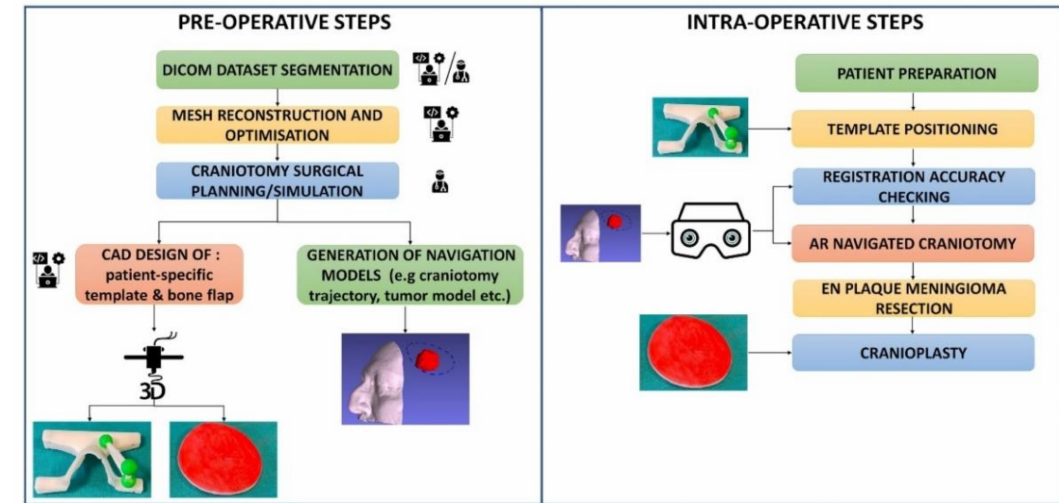
Figure 7. Description of the main pre- and intra-operative procedural steps of the operative workflow to set up the AR-based neurosurgical navigation